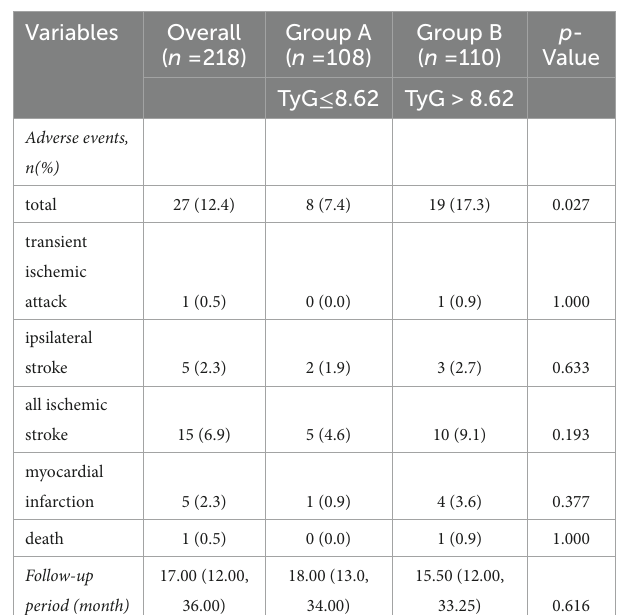
TABLE 4 Adverse events and follow-up period of the